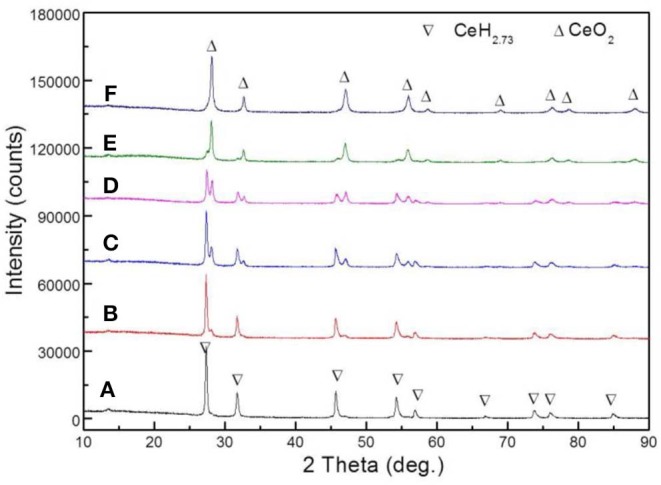
XRD images of six groups of CeH2.73/CeO2 composite catalysts obtained by oxidation of CeH2.73 for different durations: (A) 0 min, S1, (B) 0.5 min, S2, (C) 1.5 min, S3, (D) 3 min, S4, (E) 10 min, S5, (F) 60 min, S6.